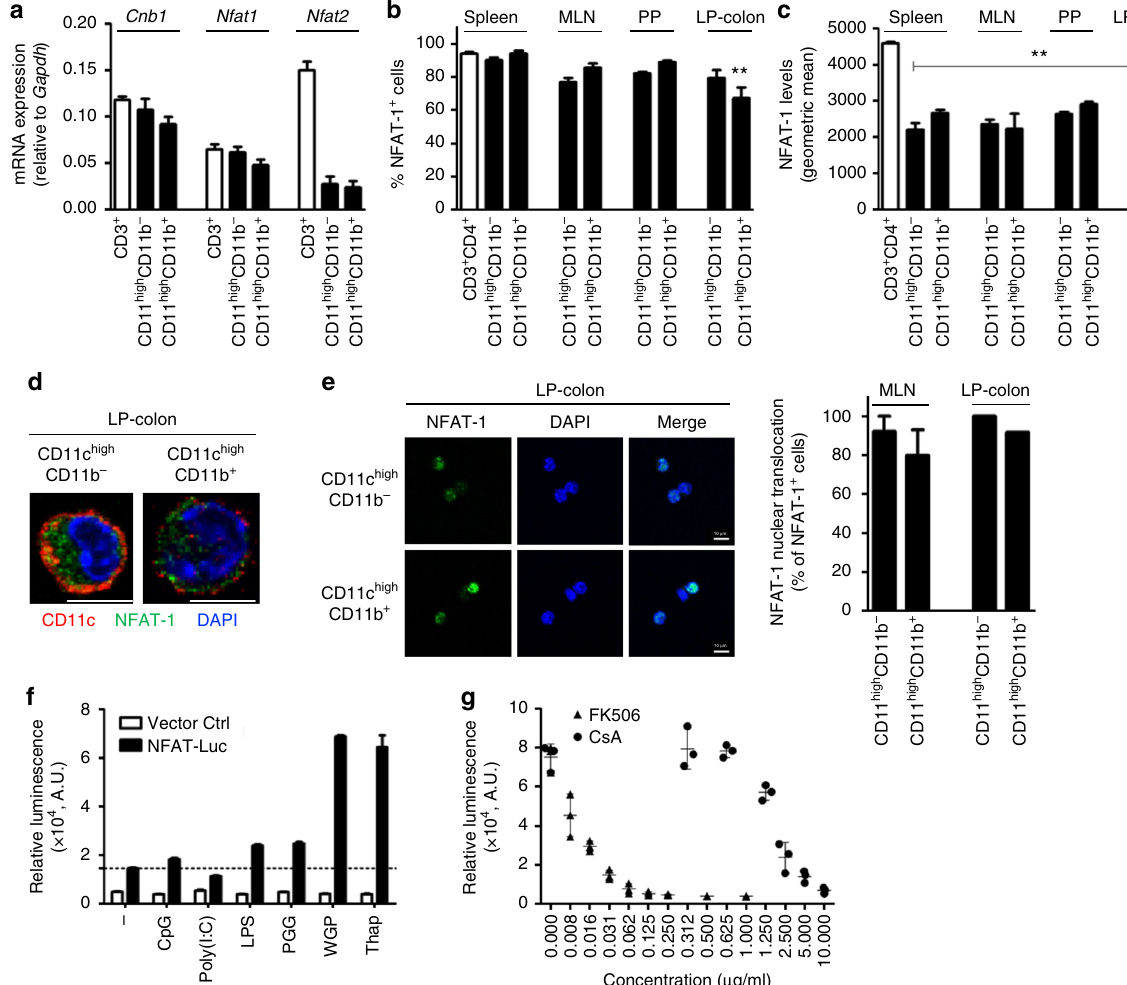
Fig. 1 Calcineurin B and NFAT expression in mouse intestinal myeloid cells. a Relative expression levels of Cnb1 , Nfat1 , and Nfat2 mRNAs in intestinal CD11c high MHCII + cells (CD11b + and CD11b − ) and MLN CD3 + T cells, assessed by qRT-PCR. Data represent the means± standard error of three experiments ( n ≥ 7 mice/exp). b , c Percentage of NFAT-1 + cells ( b ) and NFAT-1 protein levels ( c ) in CD11c high MHCII + cells (CD11b + and CD11b − ) obtained from spleen, MLN, PP, and colonic LP (LP-colon), assessed by fl ow cytometry. Splenic CD3 + CD4 + T cells are included for comparison. Data represent the means ± standard error of three experiments ( n = 4 – 5 mice/experiment). ** P < 0.01 versus CD4 + T cells (ANOVA followed by Dunnett ’ s multiple comparisons test). d Representative images of NFAT-1 labeling in sorted colonic CD11c high MHCII + cells (CD11b + and CD11b − ). Scale bar 5 μ m. e NFAT-1 nuclear translocation in CD11c high MHCII + cells (CD11b + and CD11b − ) after 30 min stimulation with thapsigargin (Thap; 200 n M ), as assessed by confocal analysis. Data represent the means ± standard error of two experiments ( n = 6 – 10 mice/experiment). Scale bar 5 μ m. f NFAT-dependent luciferase activity measured in a DC cell line in response to TLRs (Poly I:C, LPS), dectin-1 ligands (PGG and WGP), and the calcium mobilizer thapsigargin. g Dose-dependent inhibition of NFAT nuclear translocation by cyclosporin A (CsA) and tacrolimus (FK506) in WGP-stimulated D1 cells, as assessed by NFAT-luciferase activity. AU arbitrary units, Ctrl control, Luc luciferase, LP lamina propria, LPS Lipopolysaccharide, MLN mesenteric lymph node, PGG soluble β -(1,3)-glucan, PP Peyer ’ s Patches, WGP whole glucan particles, Thap